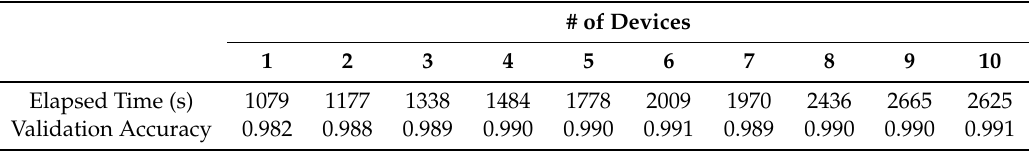
Table 2. Time and accuracy for training LeNet (convolution neural network (CNN)).